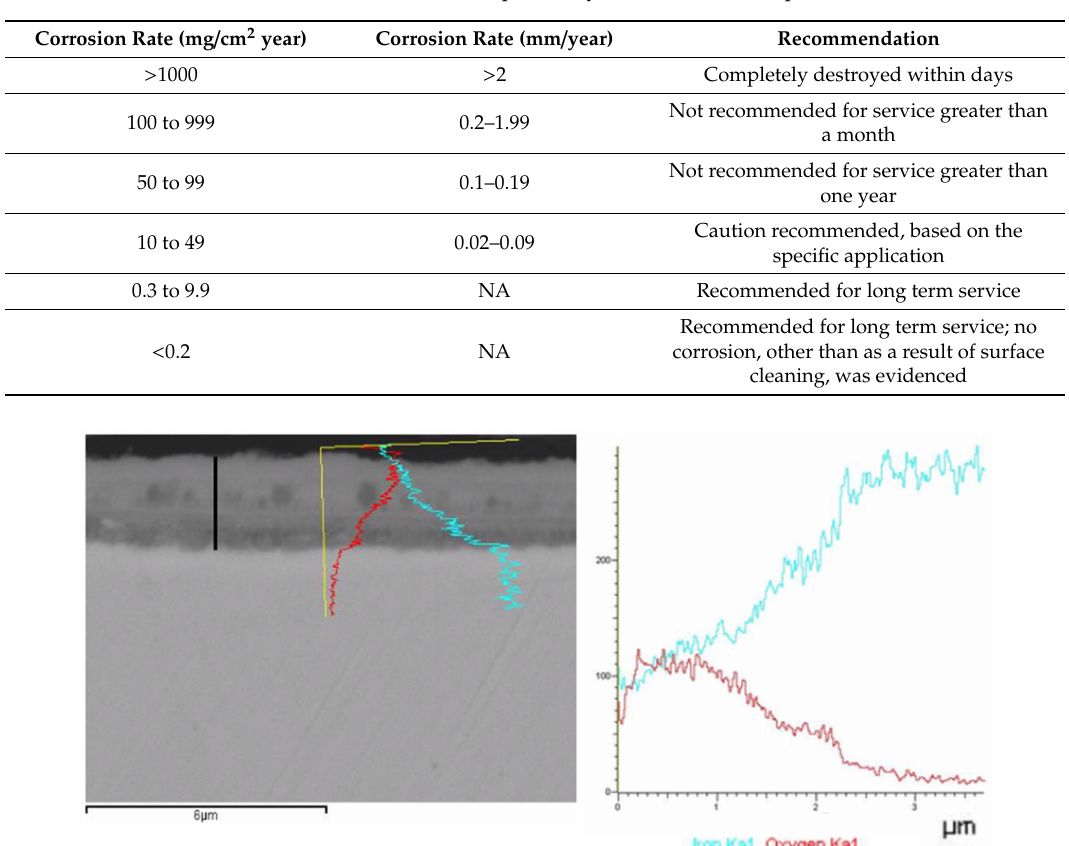
Table 6. Corrosion rate and their cooperativity in industries. Adapted from [17].